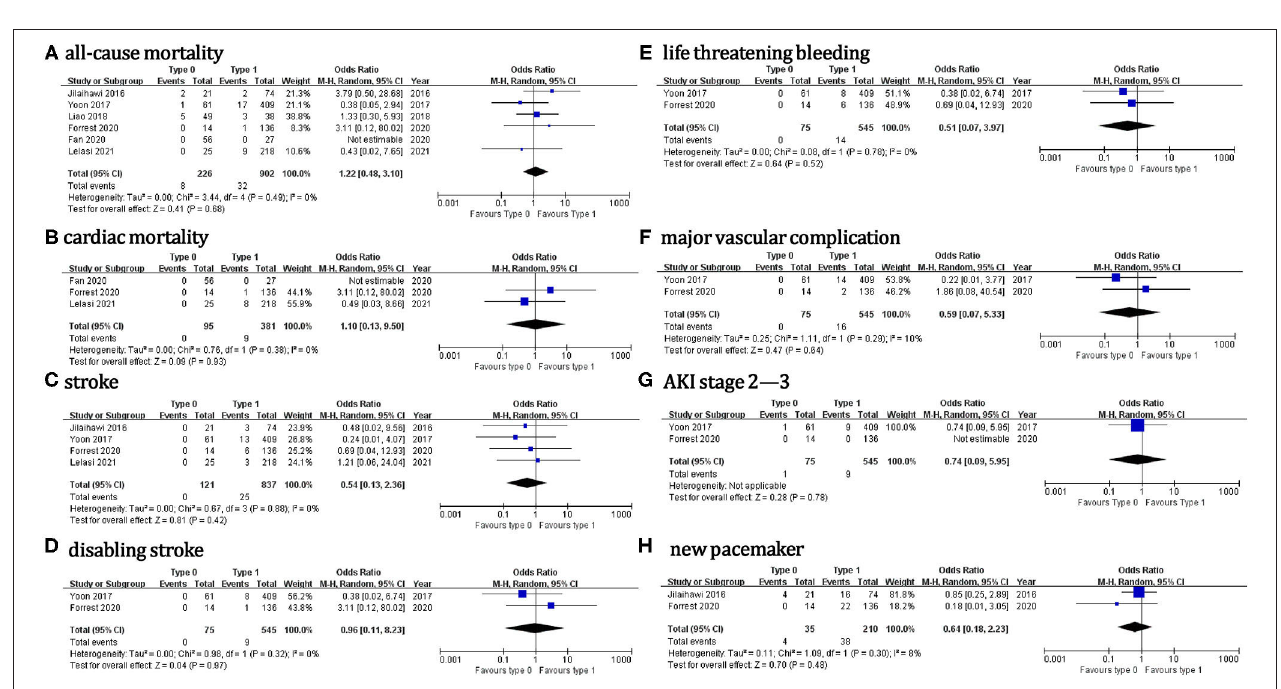
FIGURE 3 | The 30-day